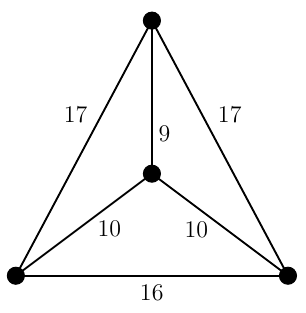
Figure 2: Tetrahedron graph from pythagorean trian- gles.